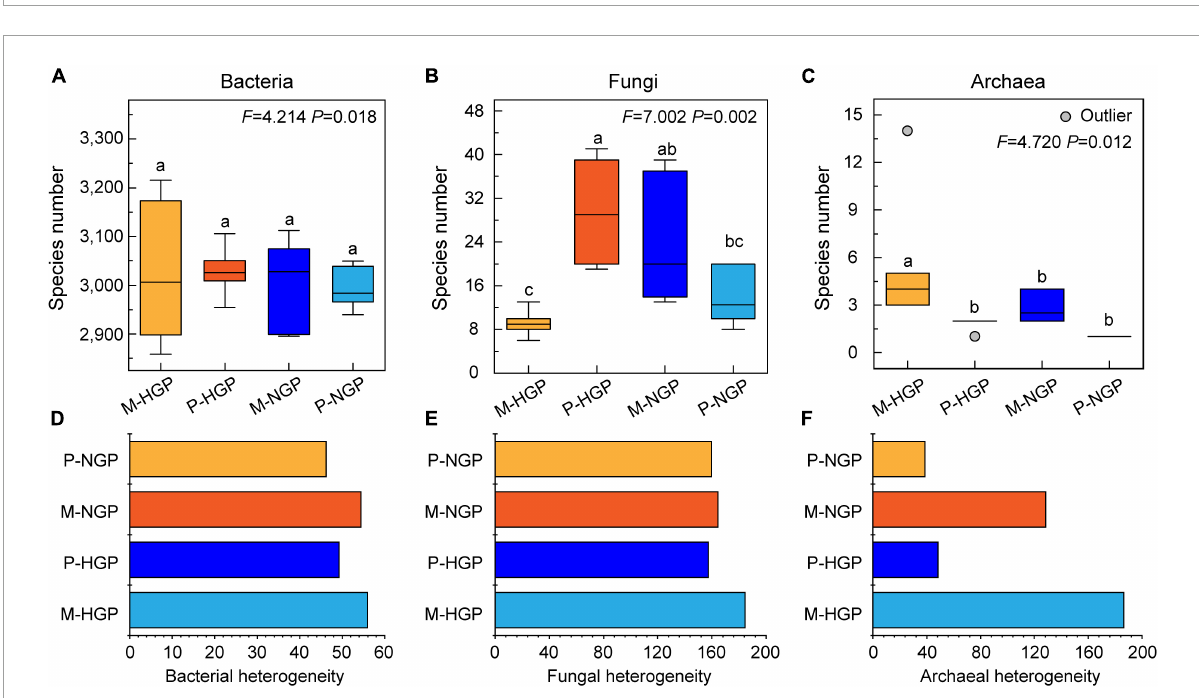
FIGURE3 Relative abundance (A–C) and heterogeneity (D–F) of soil bacteria, fungi, and archaea. In each plot, different capital letters indicate significant differences ( p < 0.05) in M-HGP, P-HGP, M-NGP, and P-NGP in (A–C) . The four sampling sites are indicated by different colors in (A–F) .